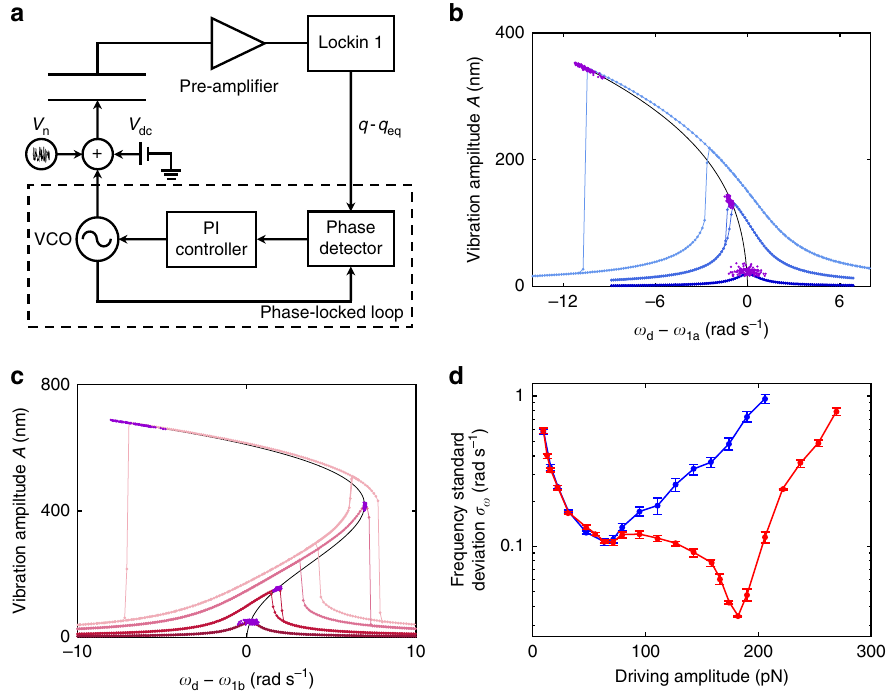
Fig. 4 Frequency stabilization in the zero-dispersion regime compared to the conventional regime. a Schematic for driving the resonator into self-sustained oscillations with a phase-locked loop. b Forced and self-sustained oscillations in the conventional nonlinear regime. With no feedback, the forced vibration amplitude as a function of driving frequency is measured at driving amplitudes of (bottom to top) 9.5, 63.35, and 158.4 pN. The solid black line represents the backbone line. With the feedback turned on and the phase delay chosen to maximize the self-oscillation amplitude, the measured distributions of the self-sustained oscillation amplitude and frequency are plotted in purple. c Similar plot for the zero-dispersion regime. From bottom to top, the driving amplitudes are 22.2, 71.3, 182, and 269pN. The stabilization of frequency in the zero-dispersion regime is demonstrated in the third curve at driving amplitude of 182 pN. d Standard deviation of the frequency of self-sustained oscillations σ ω versus driving amplitude for oscillators in the conventional regime (blue) and the zero-dispersion regime (red). The zero-dispersion regime yields the minimum standard deviation σ ð min Þ ω about a factor of ~3 smaller than that of the conventional regime. Error bars represent ±1